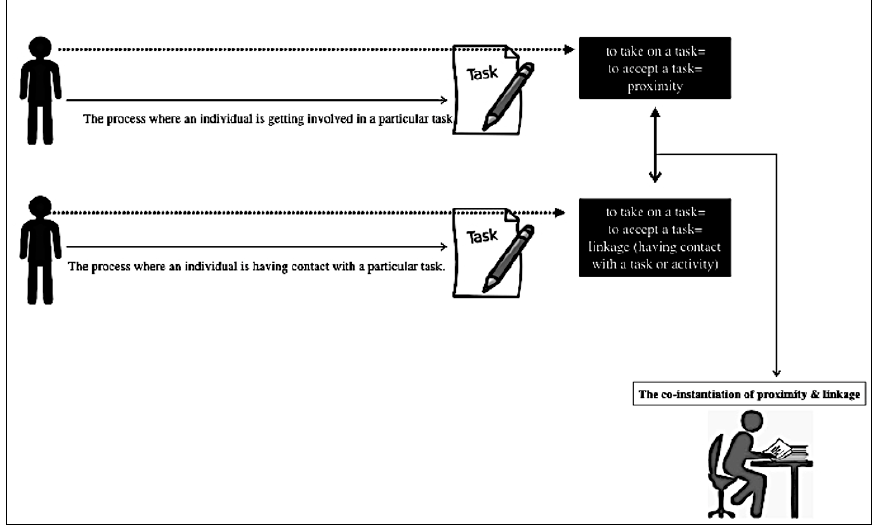
Figure 5. Take on; the co-instantiation of the PROXIMITY - DISTANCE and the LINKAGE - SEPARATION image